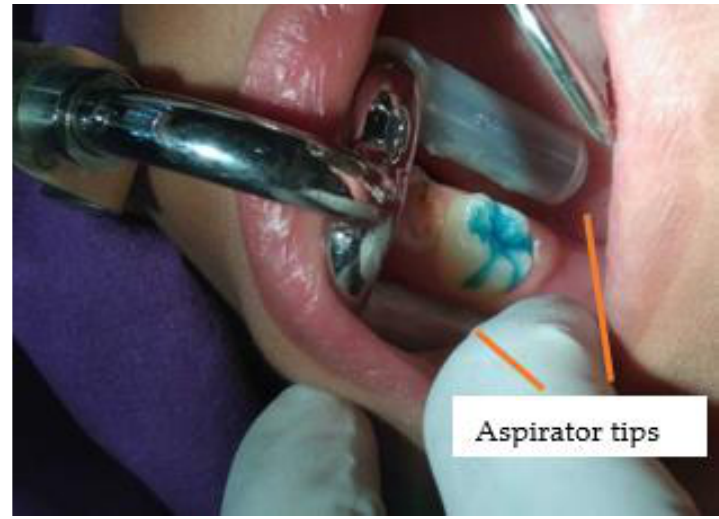
Figure 3. Intra - oral view of SS - suction in patients. Figure 3. Intra-oral view of SS-suction in